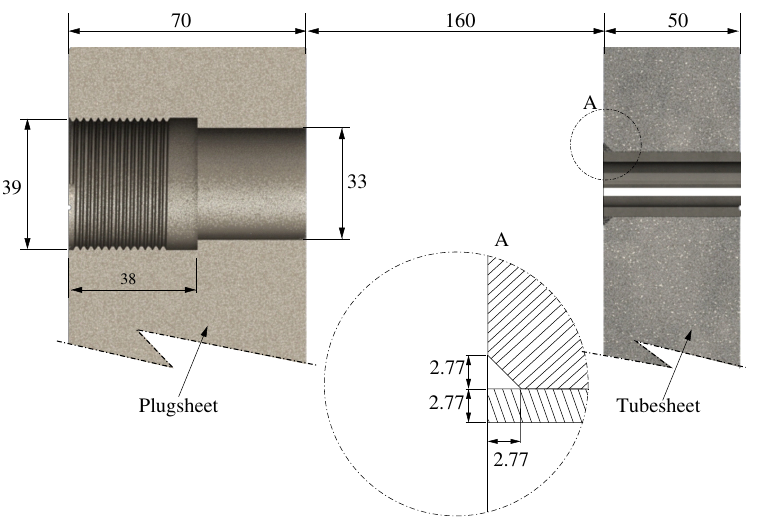
Figure 6. Disposition of plates (plugsheet and tubesheet) in the mockup. Detail A: design of the tube-to-tubesheet joint. (All measurements are in mm).